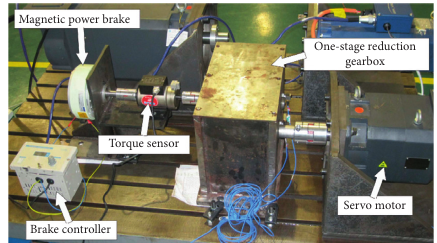
Figure 14: Experimental platform for the one-stage gearbox [2].